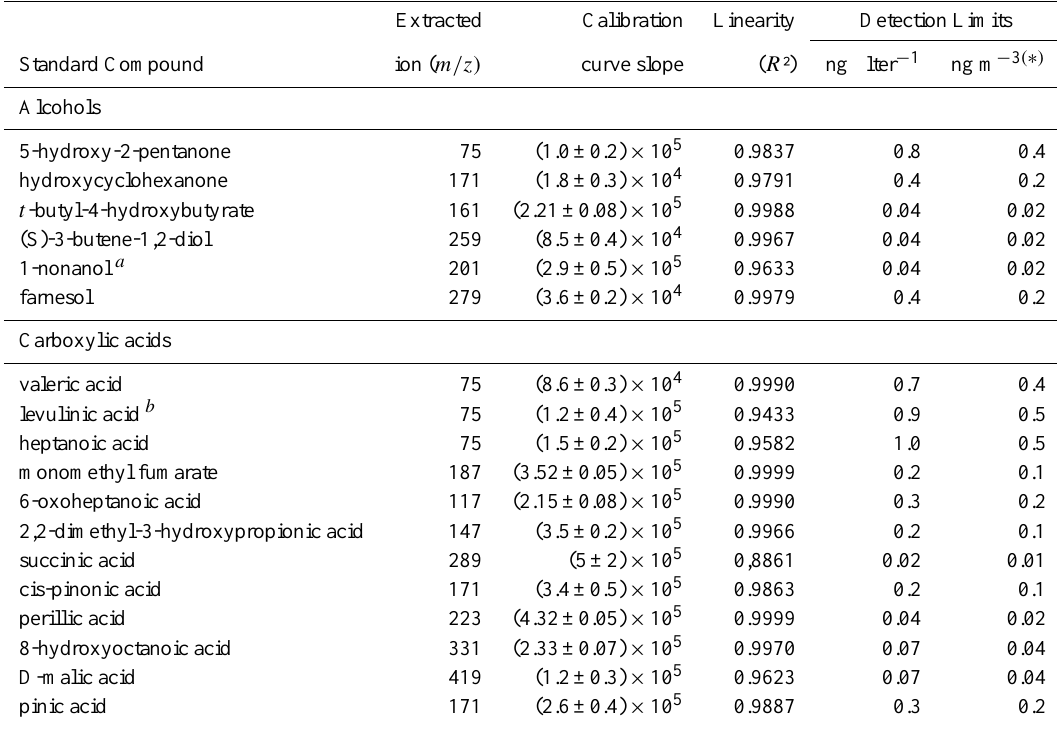
Table 5. Calibration curves slopes, linearities and detection limits for particulate hydroxyl compounds and organic acids trapped on Teflon- quartz 1 fibres filters and MTBSTFA-derivatised.